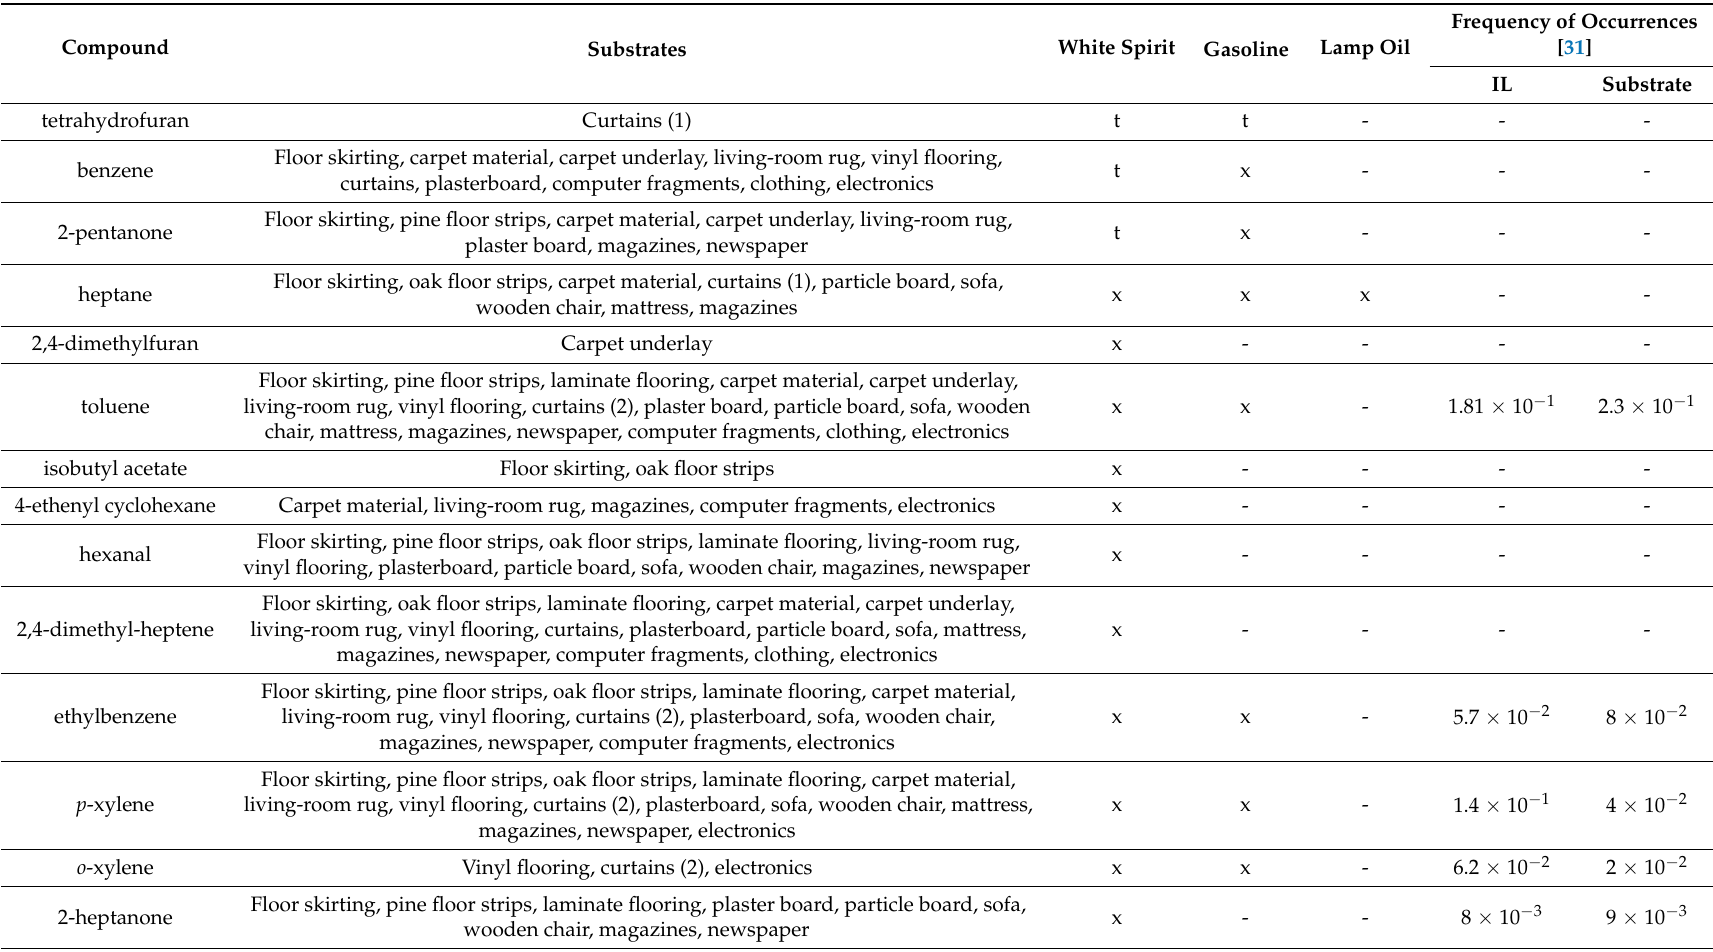
Table 5. Compounds identified in both burned substrates and intact ILs with their corresponding frequency of occurrences from Table 2 of the Sigman group article. The ‘x’ refers to compounds visibly present in the IL; the ‘t’ indicates compounds that are present on trace level.